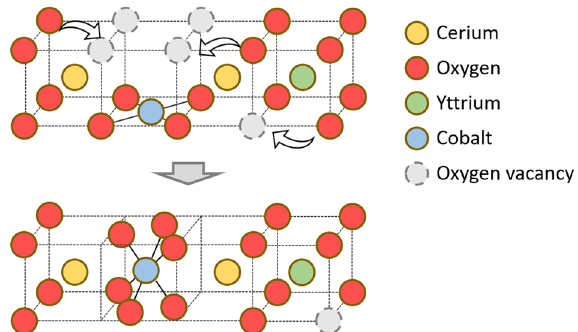
Figure 5. A simple model for the X-ray induced local structural change surrounding the Co dopant